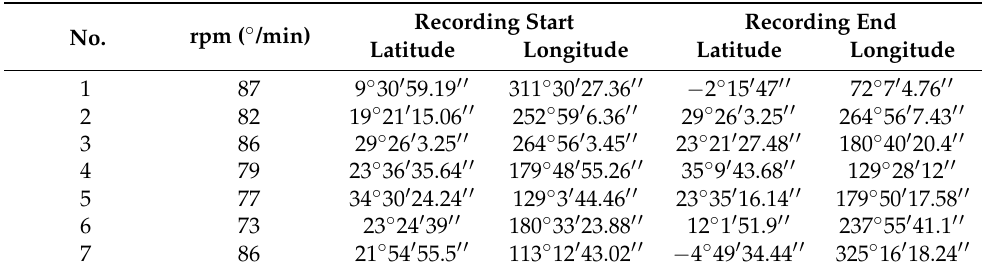
Table 1. Series of data download and